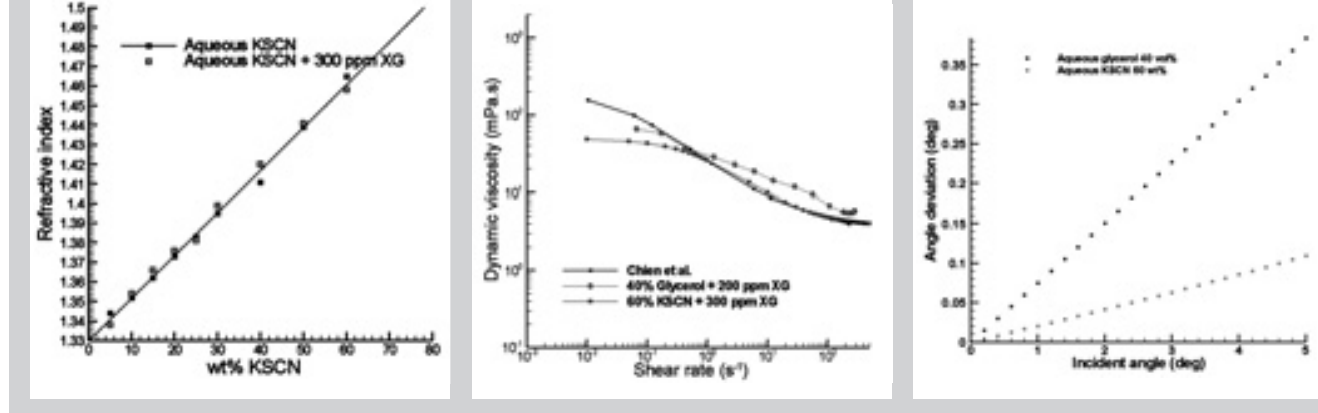
Figure 4 (left): Refractometric evolution of the aqueous potassium thiocyanate solutions with 200 and 300 ppm of xan- than gum at 25°C. Figure 5 (middle): Dynamic viscosity of experi- mental blood like fluids and physiological blood suspen- sion (Hematocrit rate of 43%). Figure 6 (right): Angle deviation for an inci- dent laser beam between 0 to